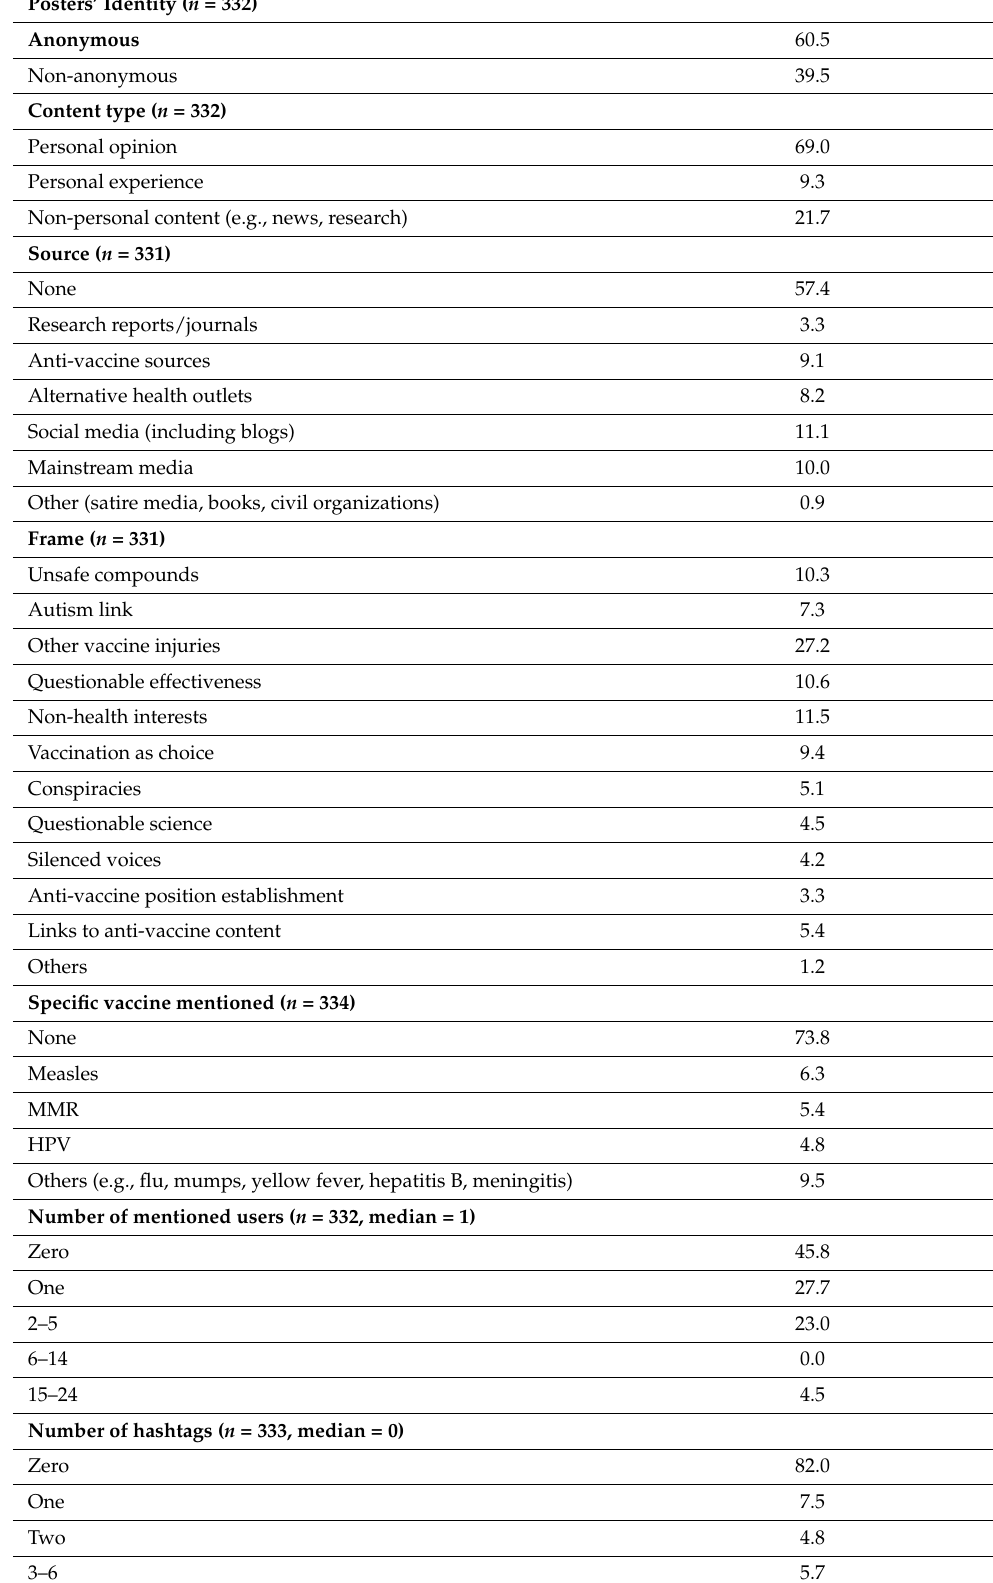
Table 2. Content characteristics of anti-vaccine